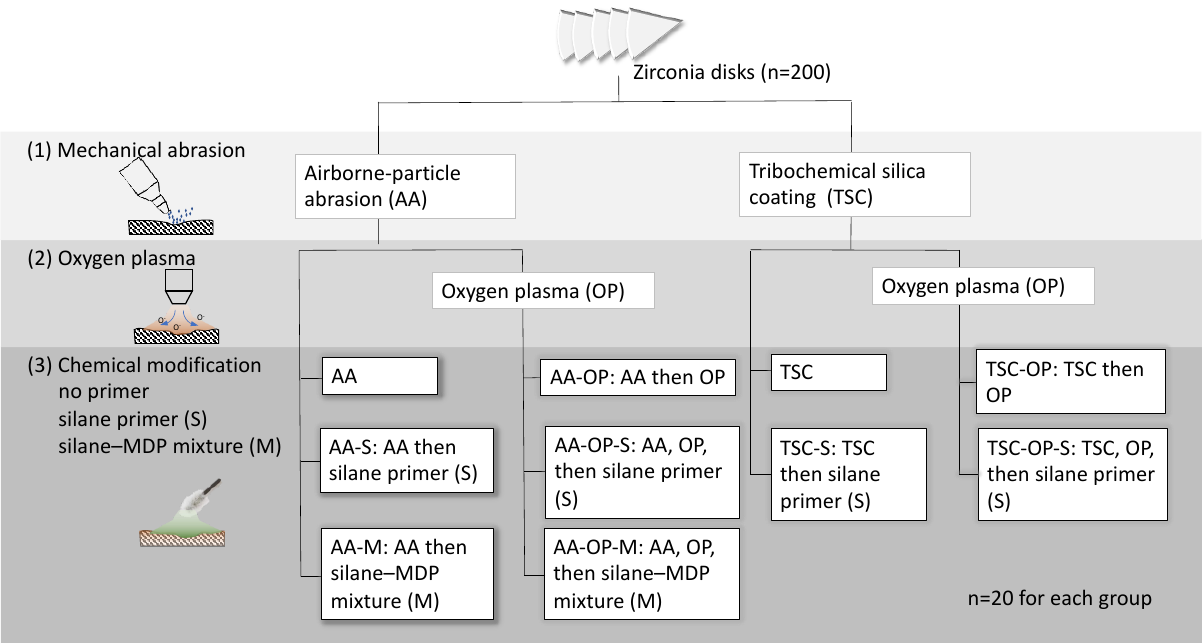
Figure 1. Treatments for the experimental